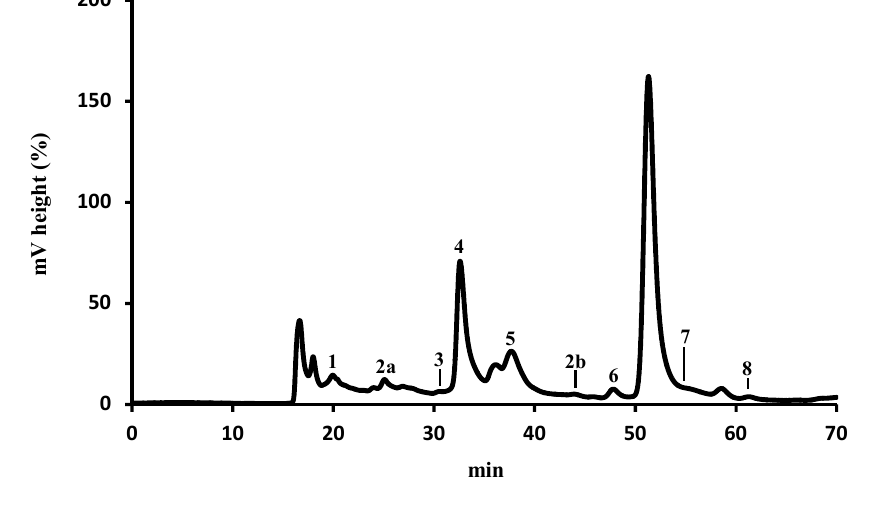
Figure 1. HPLC-UV organic acids profile of E. plantagineum hydromethanolic extract. Detection at 214 nm. Identity of compounds as in Table 1.